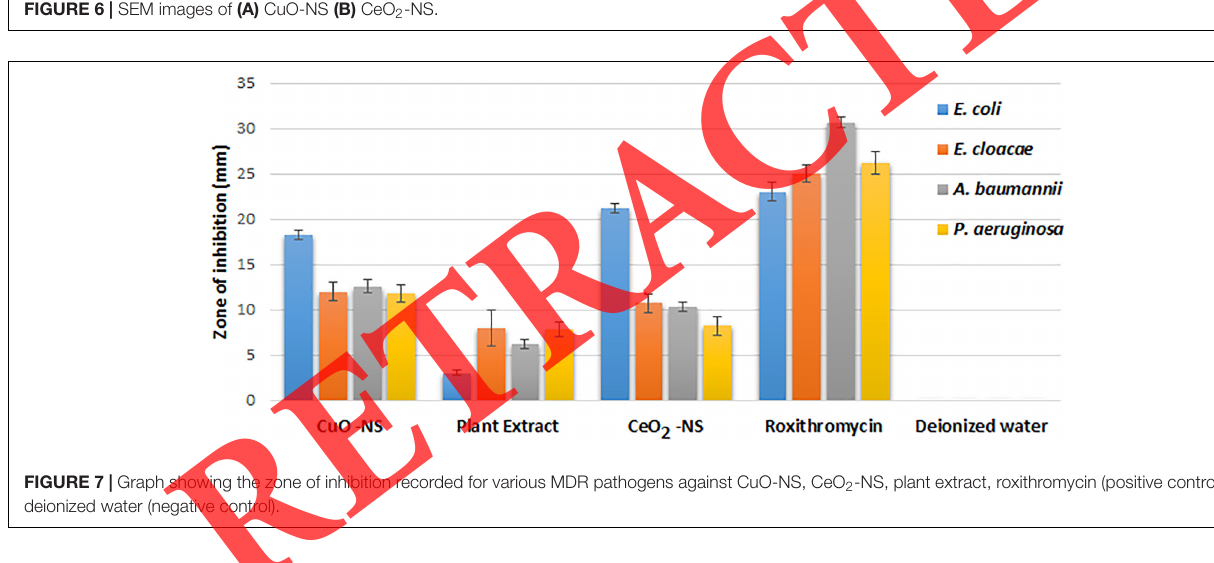
FIGURE 6 | SEM images of (A) CuO-NS (B) CeO 2 -NS.